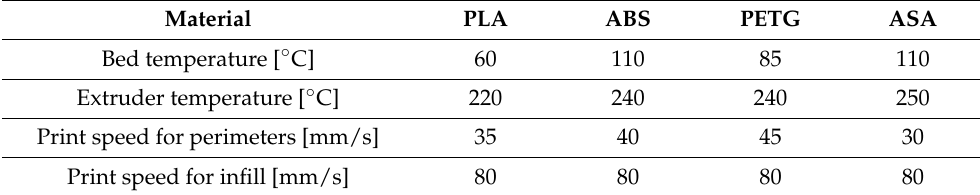
Table 3. Printing temperatures and speeds of selected materials